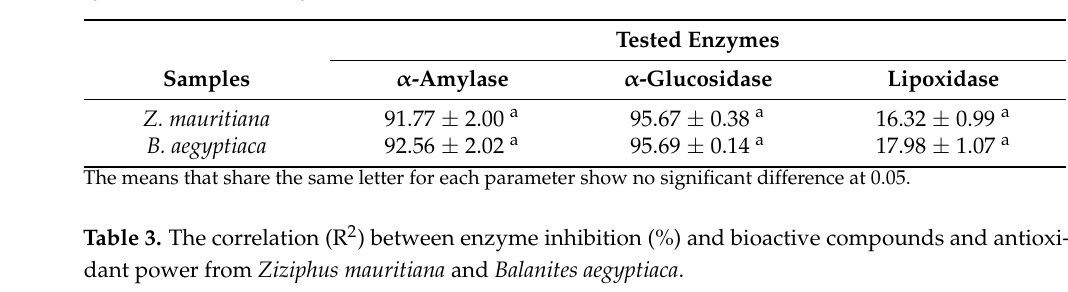
Table 2. Inhibitory effect (%) of Ziziphus mauritiana and Balanites aegyptiaca extracts on metabolic syndrome-related enzymes.